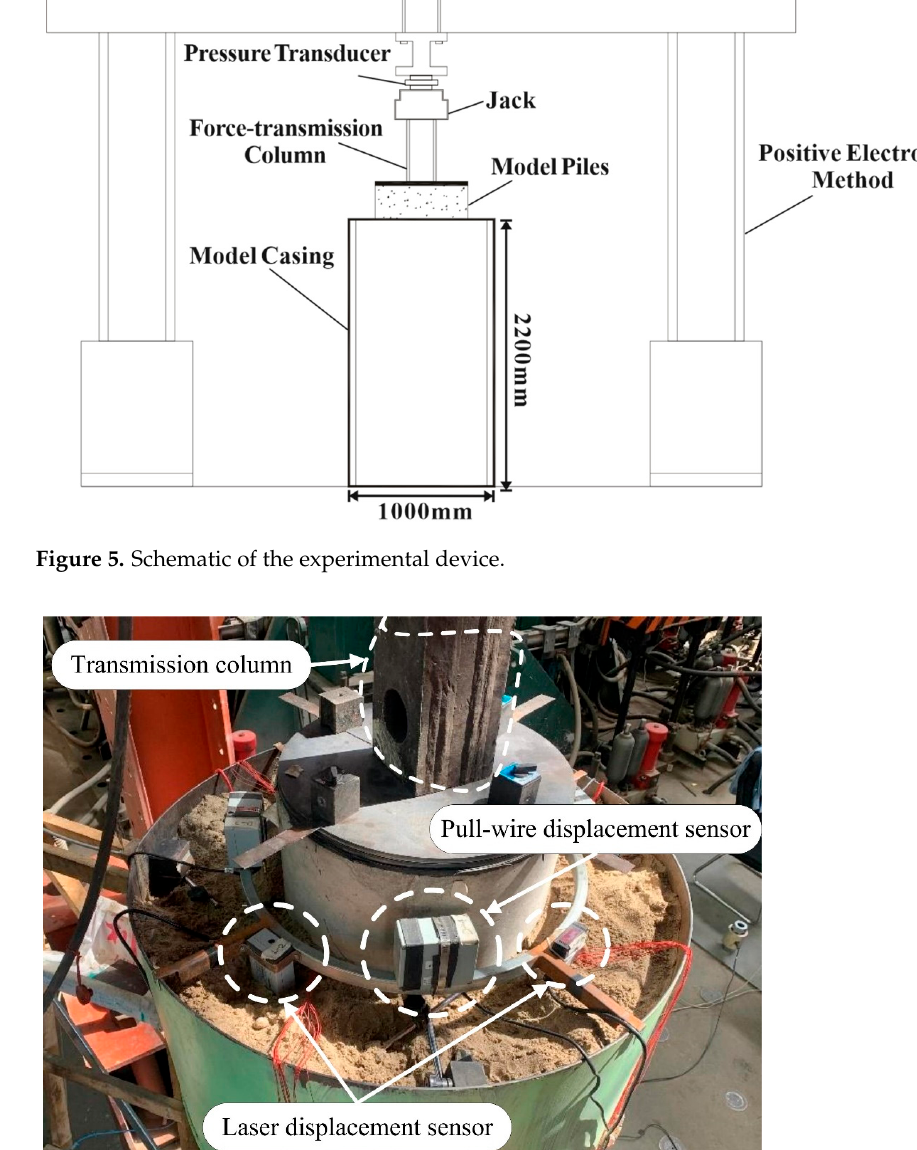
Figure 6. Experimental site.